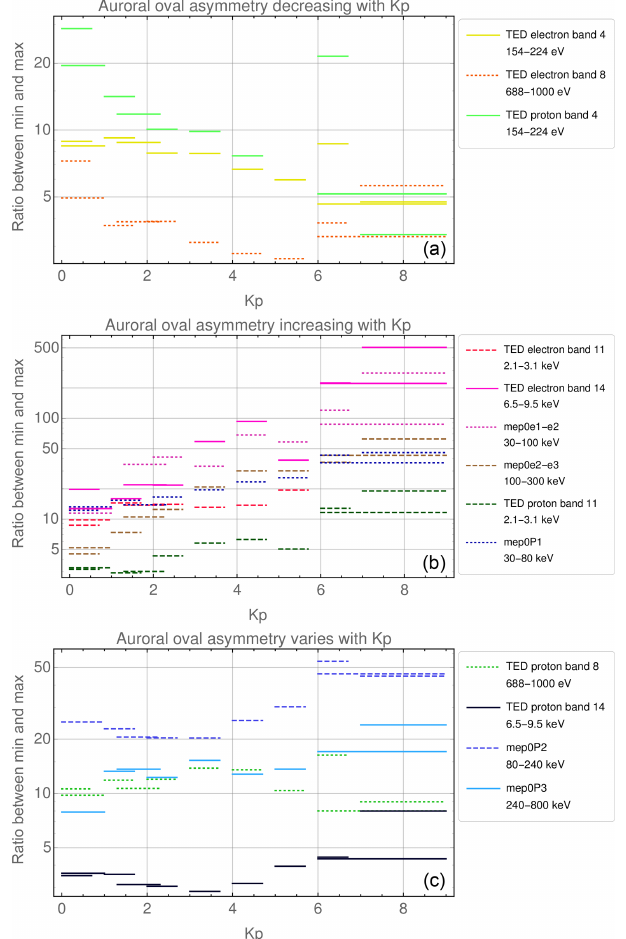
Figure 5. Dependence of the auroral oval asymmetry with Kp. (a) Channels whose auroral oval flux shows a negative correlation with Kp, (b) a positive correlation, and (c) no clear correlation.